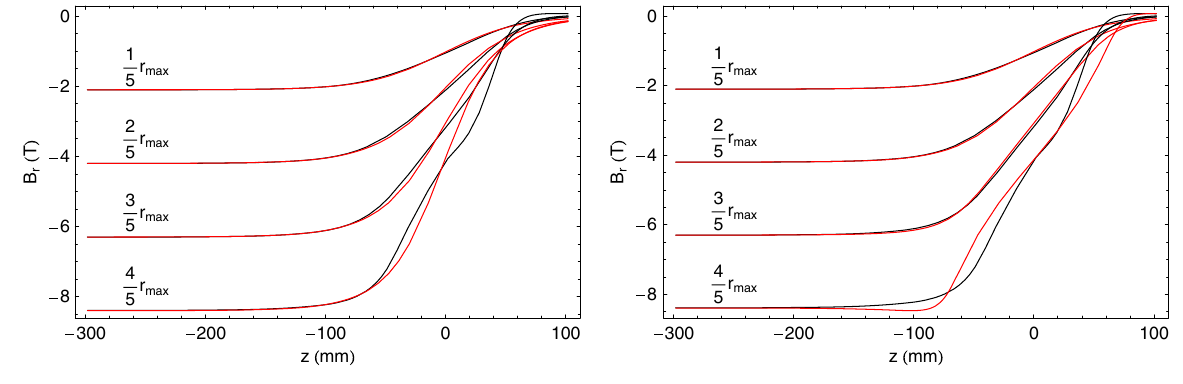
FIG. 10. As Fig. 7, but with b 2 ¼ 1 . 5 (left) and b 2 ¼ 3 . 5 (right).